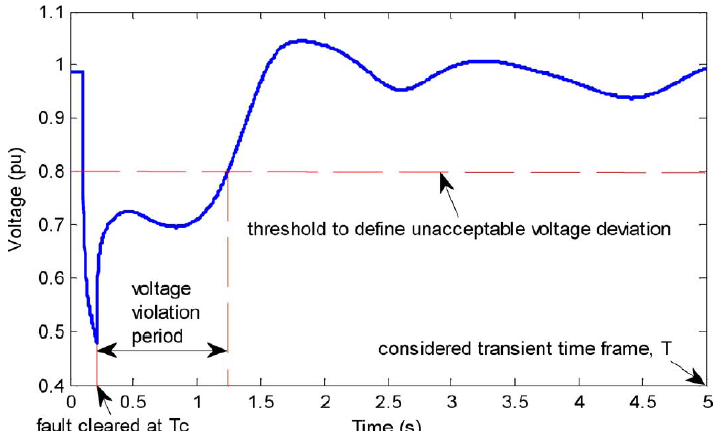
Figure 3. Illustration of the TVDI concept on an example of a fault-induced voltage drop [20]. Copyright: IEEE. Copyright permission from